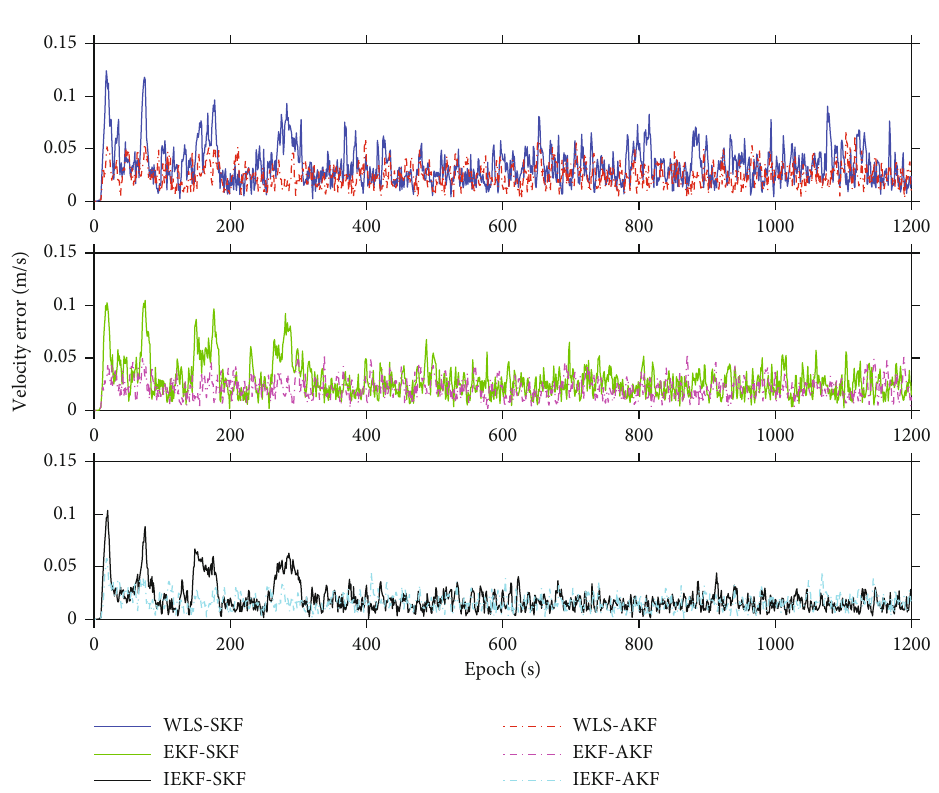
Figure 14: The velocity errors of various algorithms (Data